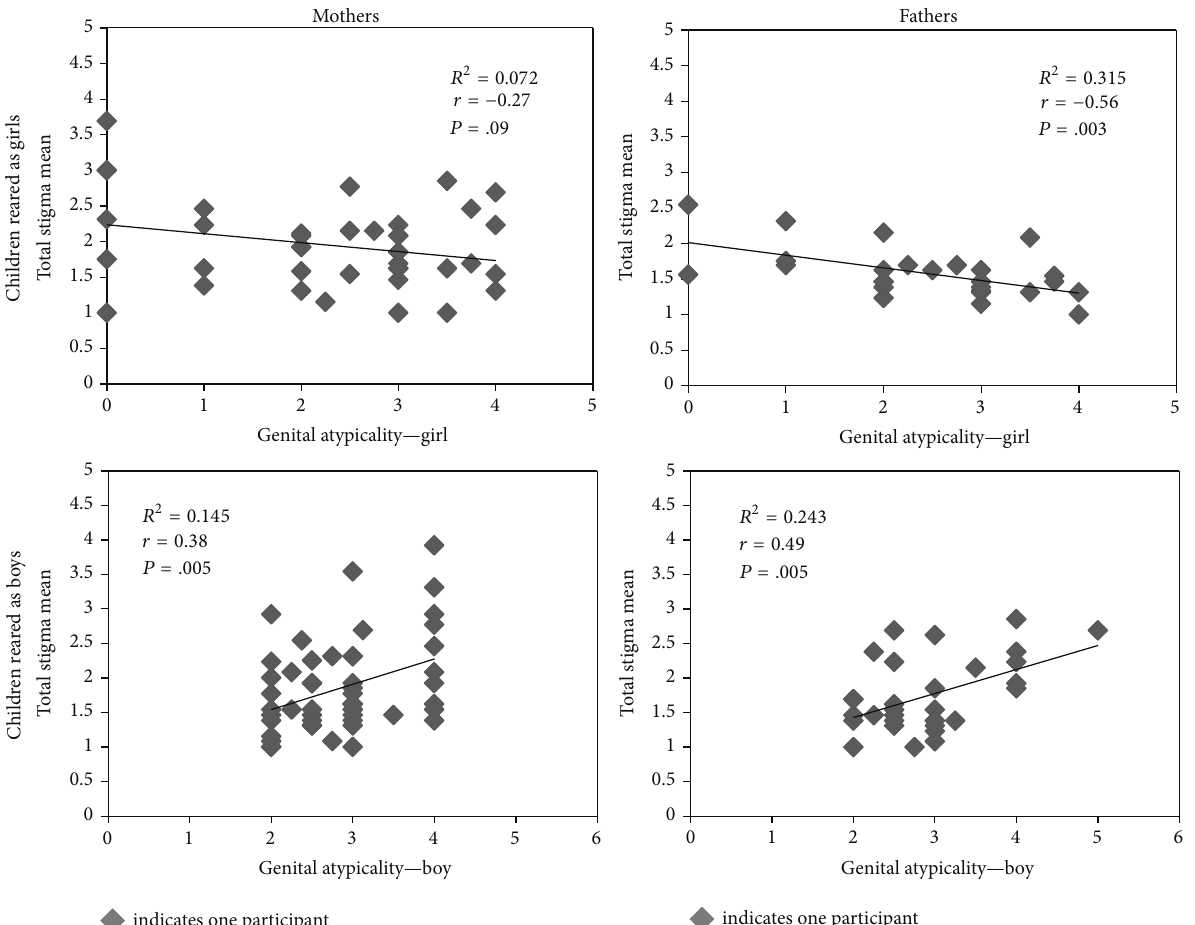
Figure 1: Parent ratings of stigma as a function of child’s gender of rearing and degree of genital atypicality at birth. Note: correlation of genital atypicality and stigma subscales not shown, but trends are the